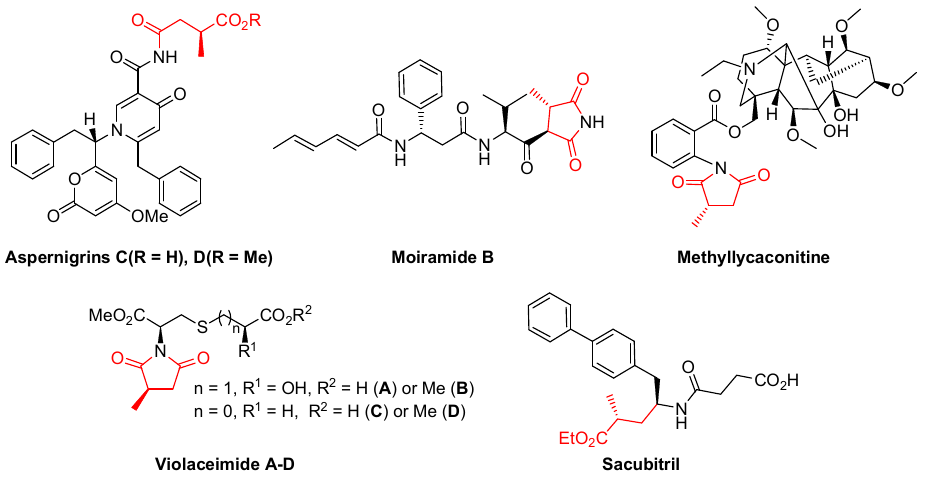
Figure 1. Examples of bioactive natural products and drugs derived from chiral dimethyl 2-methylsuccinate ( 1 ).